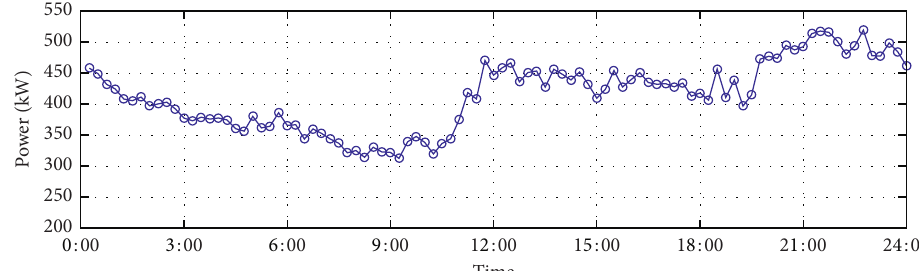
Figure 18: Daily load curve in residential area number 1.